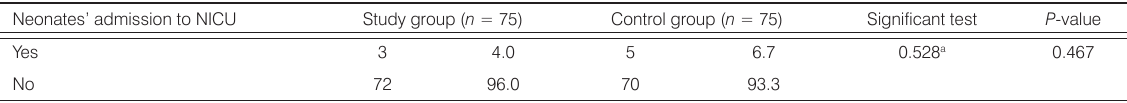
Table 5. Neonates’ admission to Neonatal Intensive Care Unit (NICU) ( n =